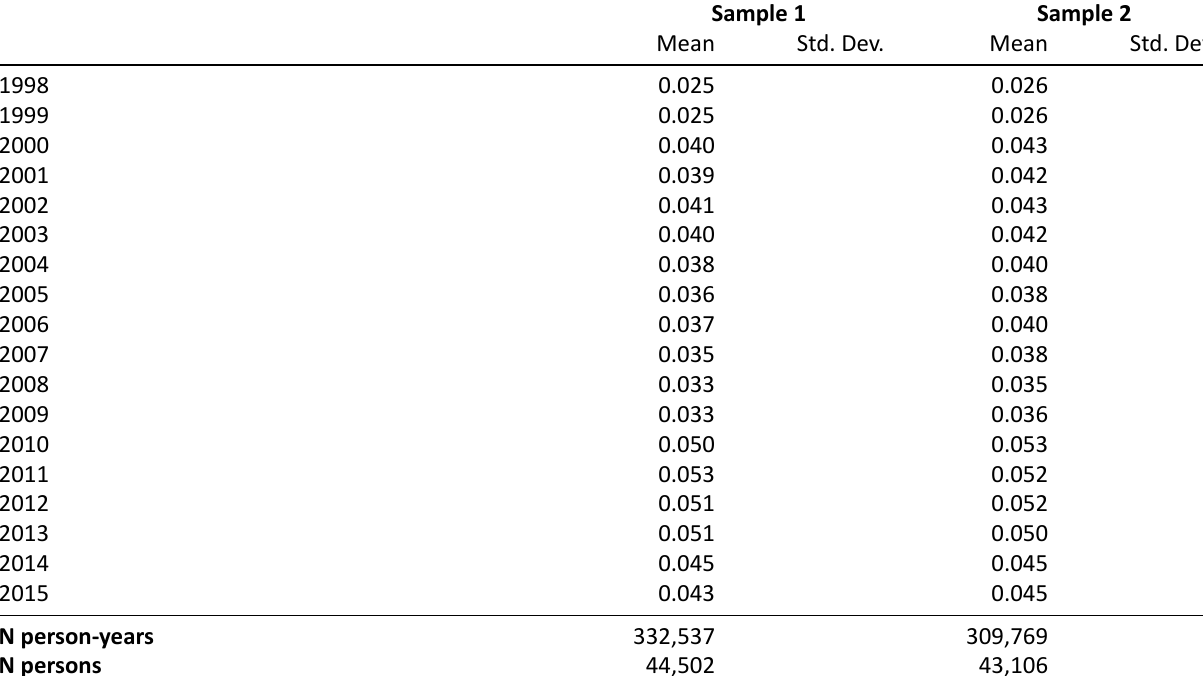
Table A1. (Cont.) Distribution of model variables in sample 1 and sample 2. Data source: GSOEP